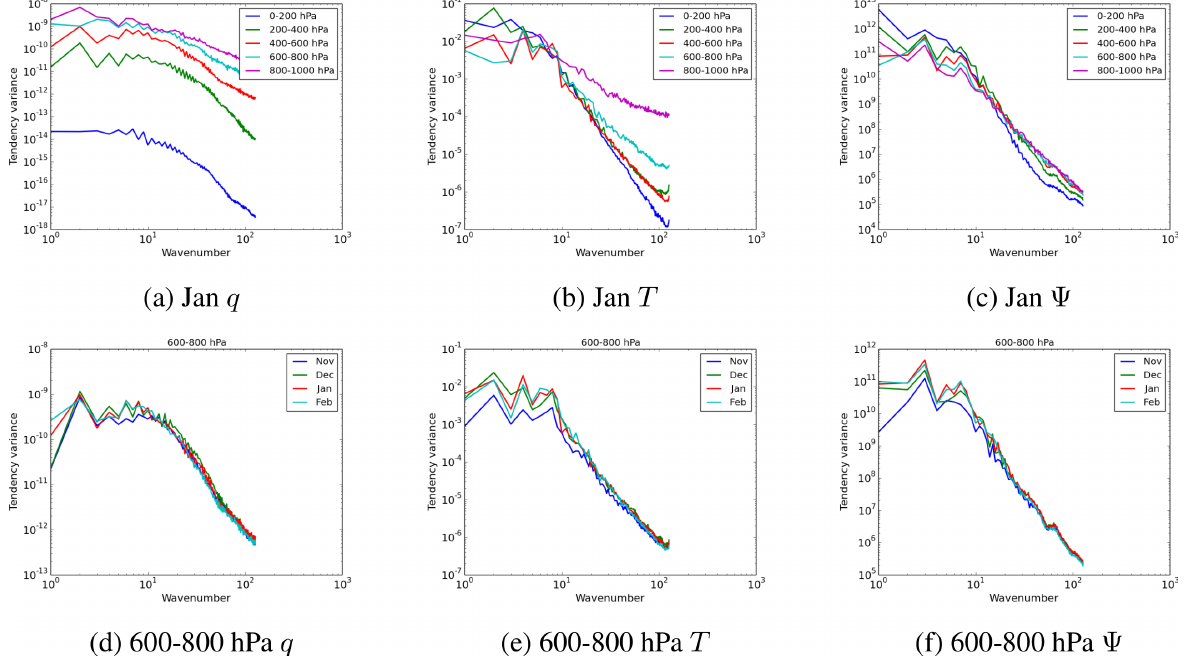
Figure 1. Spectral amplitude of corrections for (from left to right) specific humidity, temperature, and streamfunction for January 1980–2013 integrated over 200hPa layers of the atmospheric model (top row), and for each month of the nudged runs for the 600–800hPa layer (bottom row). Values are calculated with raw δX spectral fields (corrections per model time